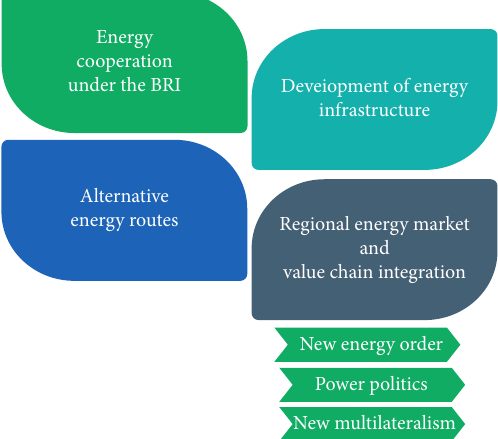
Figure 13: Conceptual framework of the